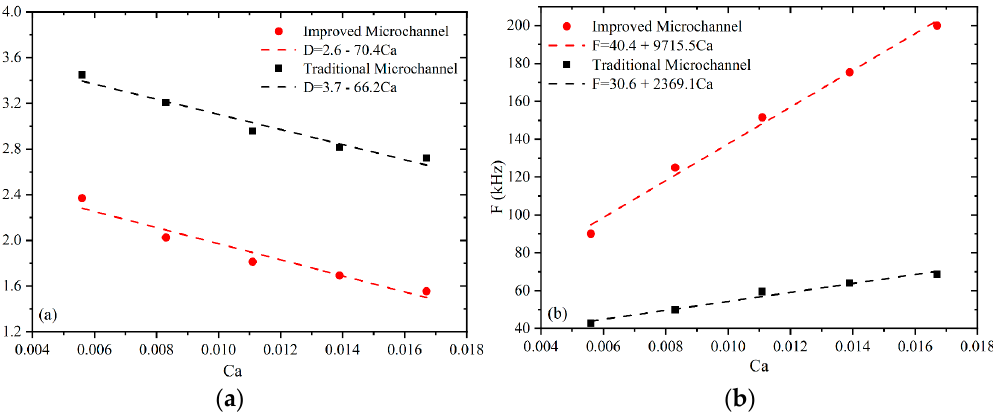
Figure 14. ( a ) Microbubble diameter (D) and ( b ) generation frequency (F) as a function of capillary number (Ca) (U d = 0.2 m/s).